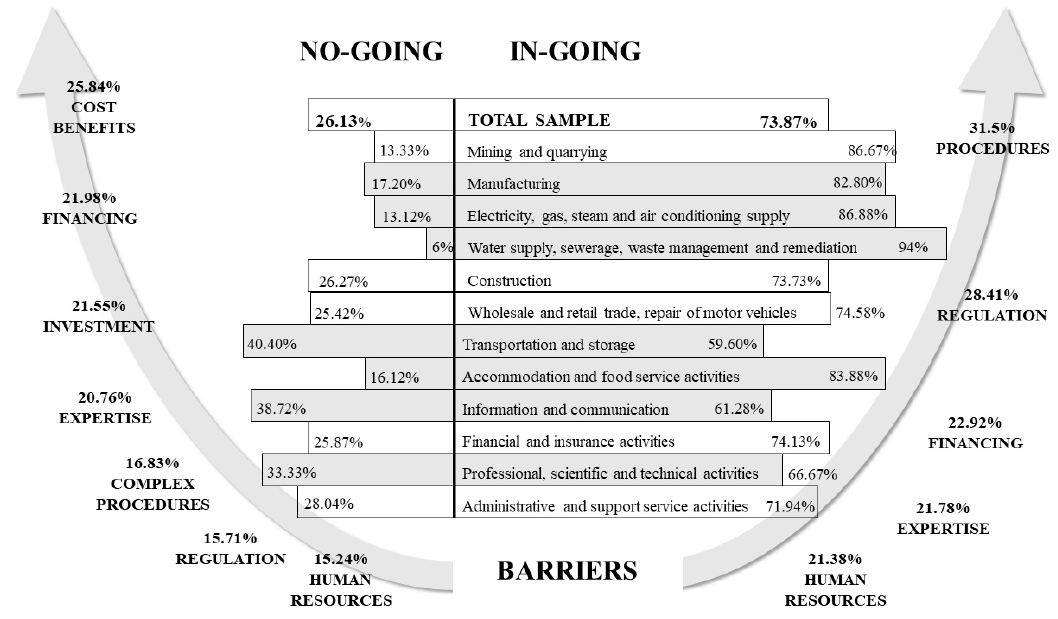
Table 3. Sample distribution. In-Going and No-Going firms.